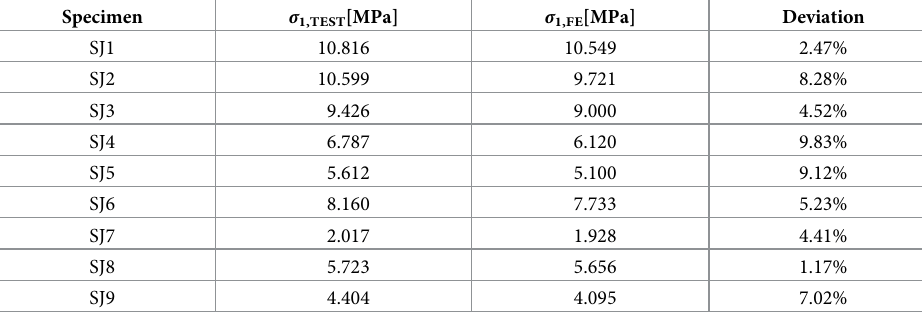
Fig 13. The nephogram in FEA of. (a)SJ1, (b)SJ2 of stress; (c)SJ1, (d)SJ2 of deflection. https://doi.org/10.1371/journal.pone.0250463.g013 Table 6. Comparison of plate central deflection between simulation and